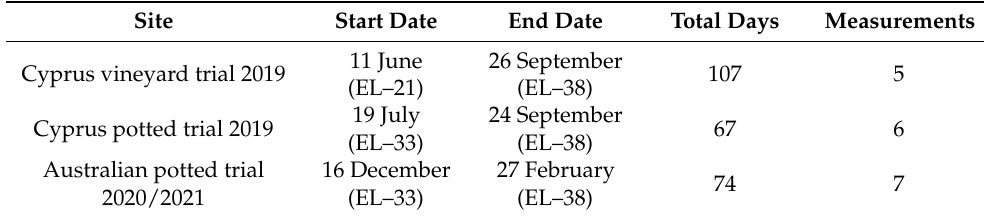
Table 1. Trial data collection timetable for 2019,